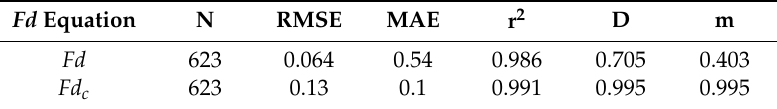
Table 2. Statistical indicators of Granier’s ( Fd) and model performance ( Fd c ) as compared to the